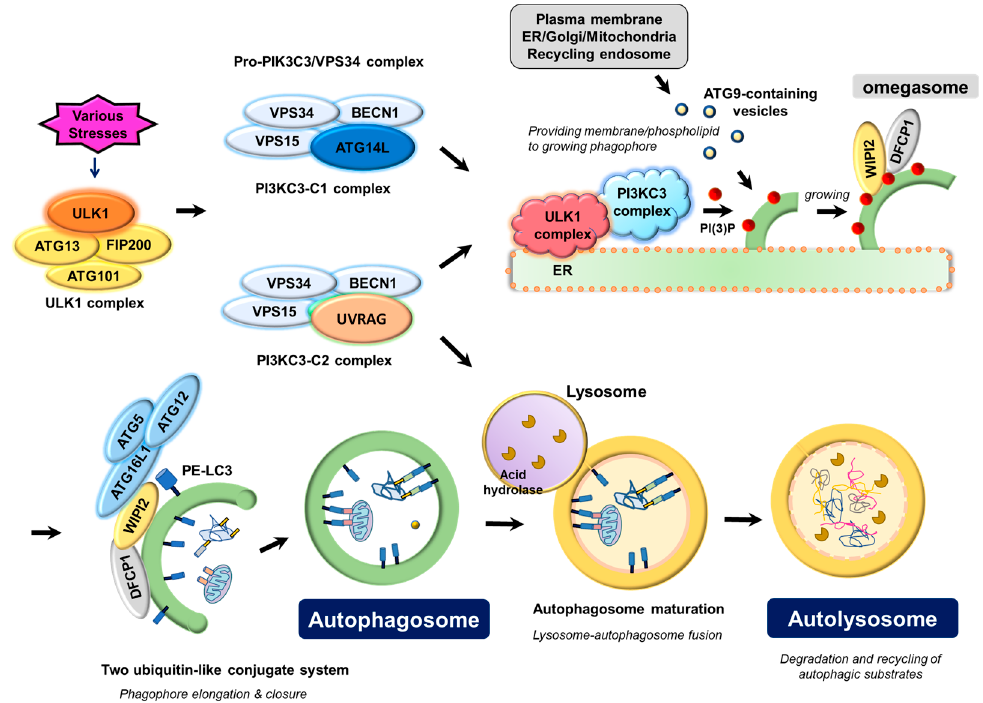
Figure 1. Molecular mechanism underlying autophagosome biogenesis by the coordinated actions of ATG proteins. Upon various stresses, the ULK1 complex, consisting of the catalytic subunit ULK1 protein kinase and its associated-regulatory subunits such as ATG13, FIP200, and ATG101, triggers nucleation of the phagophore by phosphorylating and activating the pro-autophagy PIK3C3/VPS34 lipid kinase complex containing either ATG14L (PI3KC3-C1) or UVRAG (PI3KC3-C2), which in turn marks a distinct ER membrane with its phospholipid product, PI(3)P, to form omegasome. PI(3)P on omegasomes then recruits the PI(3)P effector proteins, WIPI2 (WD repeat domain phosphoinositide- interacting protein 2) and DFCP1 (zinc-finger FYVE domain-containing protein 1). WIPI2 and DFCP1